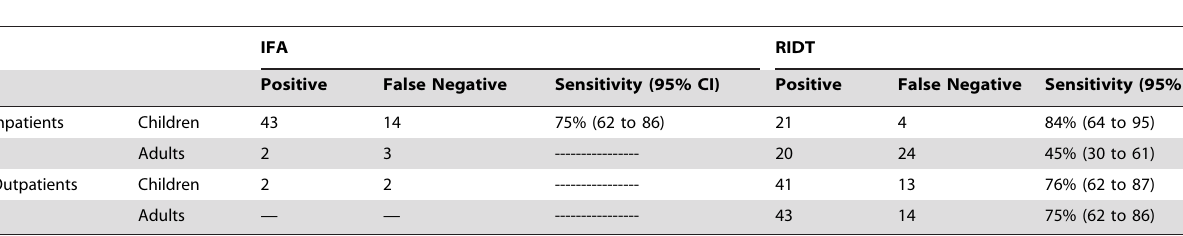
Table 1. Comparison of Sensitivity for RIDT and IFA Tests by Severity and Age using PCR as the Gold